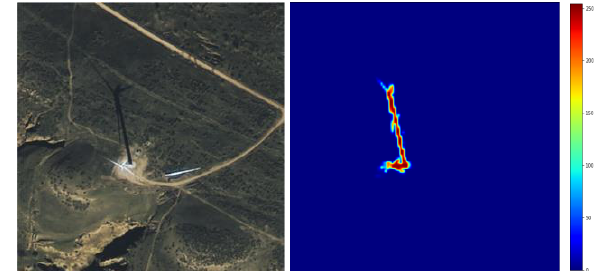
Figure 6. The score map of a wind turbine in test image